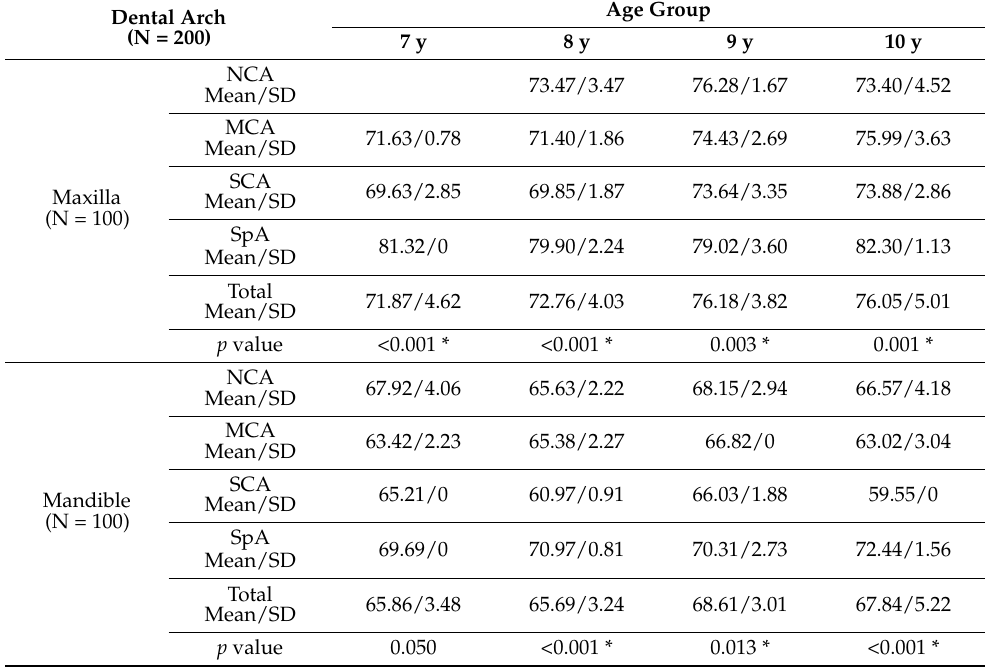
Table 4. Total available space for upper and lower arches related to age; significant differences among subgroups according to ANOVA